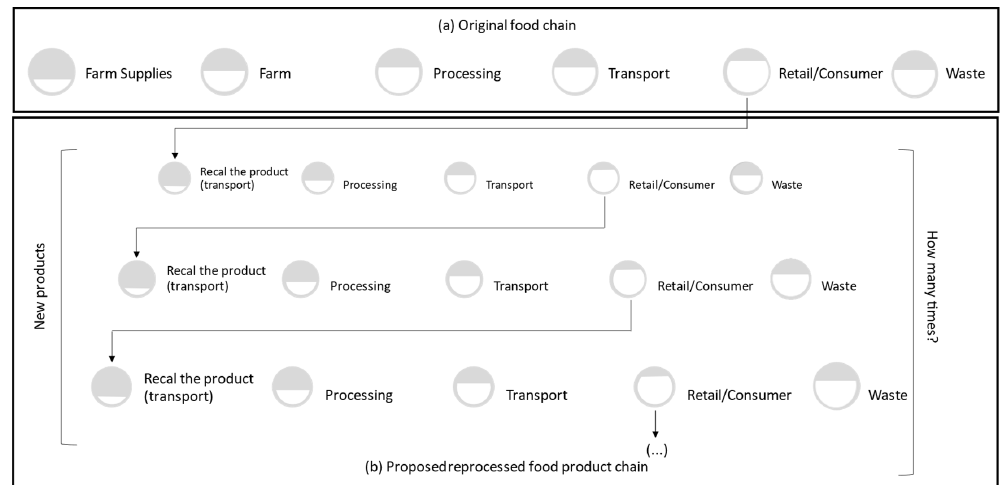
Figure 2. Relative environmental impact of ( a ) a generic food product (original food chain) and ( b ) potentially increased accumulated impact of a reprocessed food (reprocessed food product chain). The shaded circles represent the product’s total environmental impact, whereas the white parts represent each stage of the chain’s contribution to the total impact. While avoiding waste production via diversion and repurposing of food biomass, there will be a limit to the number of cycles that make recycling viable without increasing the product’s environmental impact when wasted